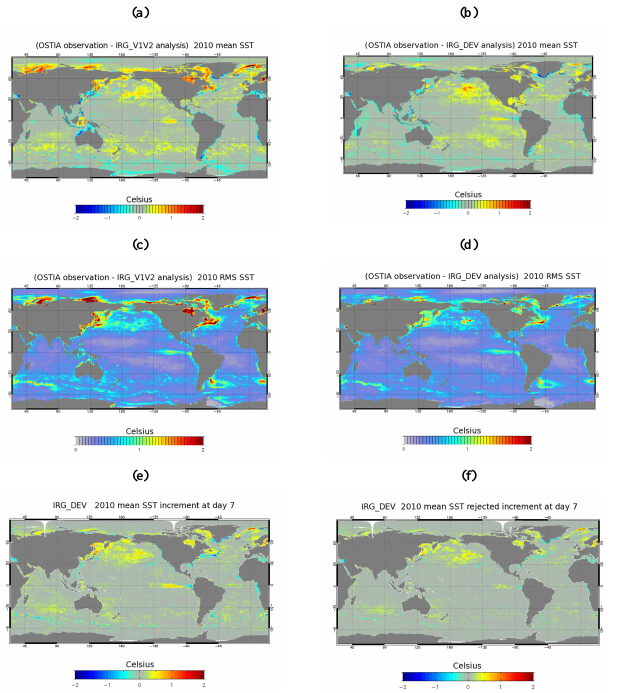
Fig. 9. 2010 SST (°C) mean ( a and b ) and RMS ( c and d ) differences (observation minus 1 Fig. 9. 2010 SST ( ◦ C) mean ( a and b ) and RMS ( c and d ) analysis) between OSTIA product and IRG daily average analyses collocated with 2 differences (observation minus analysis) between OSTIA prod- observations. IRG_V1V2 system ( a and c ) assimilates RTG SST and is compared to 3 uct and IRG daily average analyses collocated with observa- IRG_DEV system ( b and d ) which assimilates AVHRR+AMSRE SST. (e) 2010 mean SST 4 tions. IRG V1V2 system ( a and c ) assimilates RTG SST and increment injected into IRG_DEV system every 7 days. (f) 2010 mean SST increment 5 is compared to IRG DEV system ( b and d ) which assimilates AVHRR+AMSRE SST. (e) 2010 mean SST increment injected into IRG DEV system every 7days. (f) 2010 mean SST increment re- jected by the system every 7days. Note that the rejected increment corresponds to the increment weighted by the distribution function (see Fig. 4) minus the difference between the analysis and the back- ground.